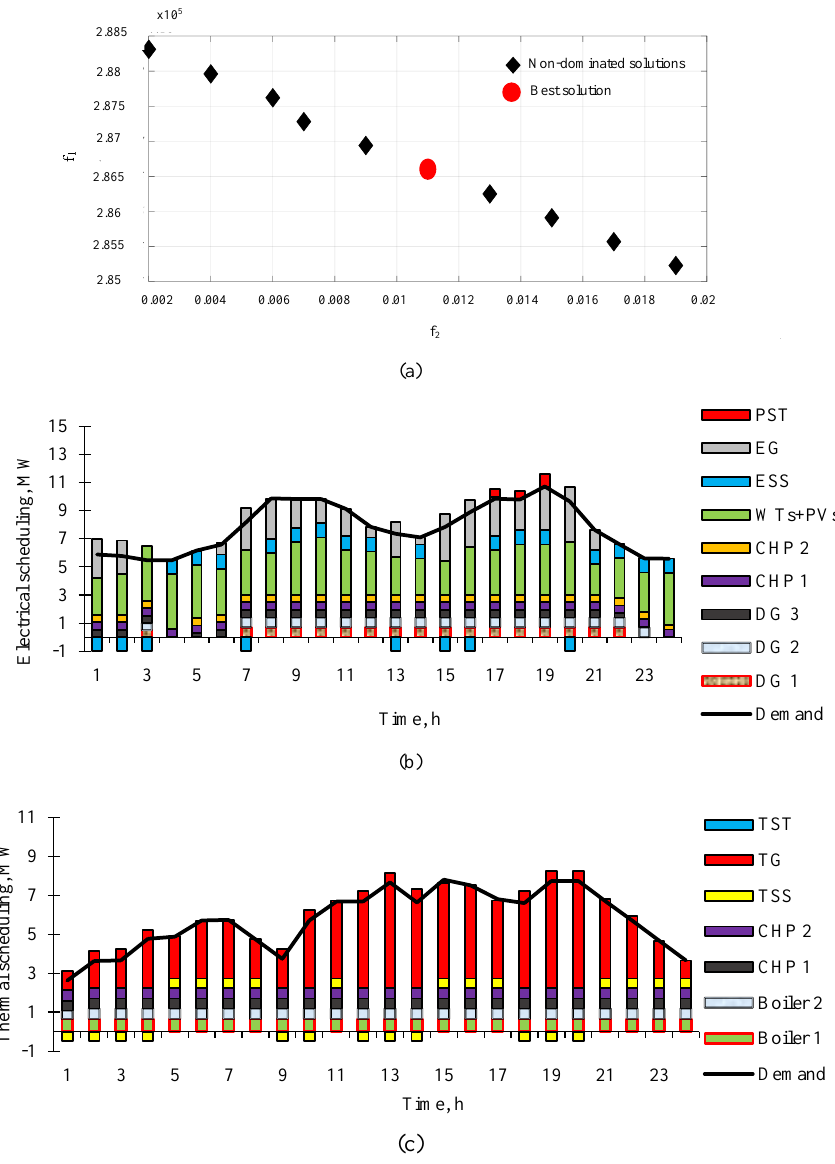
Fig. 7. (a) Selection of best solution in Non-dominated solutions in Case I, (b) Electrical power generated in Case I and (c) Thermal power generated in Case